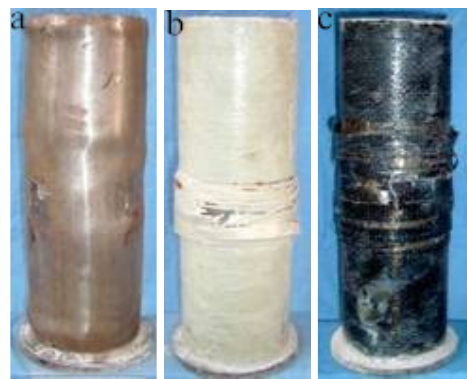
Figure 2. Typical failure modes: ( a ) concrete-filled steel tube (CFST) specimen; ( b ) GFCFST specimens; ( c ) CFCFST